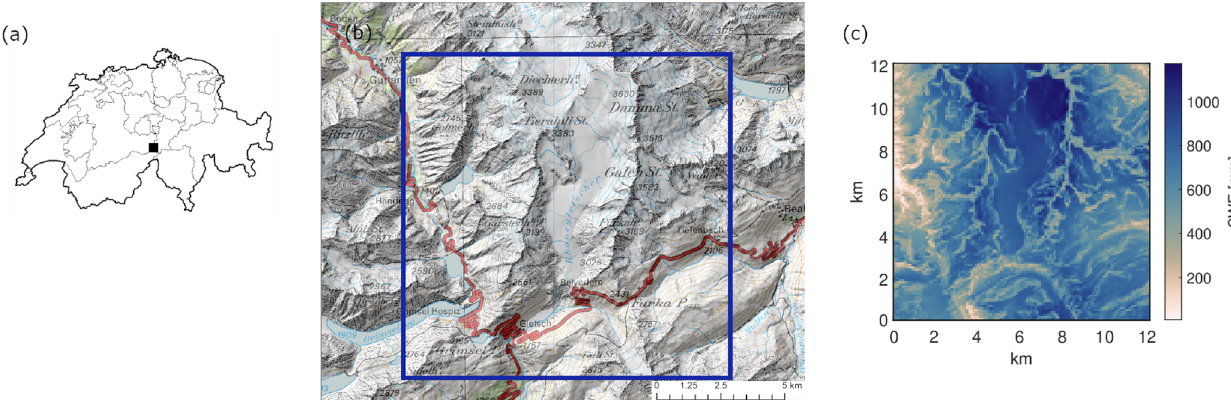
Figure 1. Location of the study area in Switzerland (46.56 ◦ N, 8.36 ◦ E; WGS 84) (a) and map showing the extent of the model domain (source: Federal Office of Topography swisstopo) (b) . Example of modelled SWE on 1 April of a random year during current-climate conditions (c) .